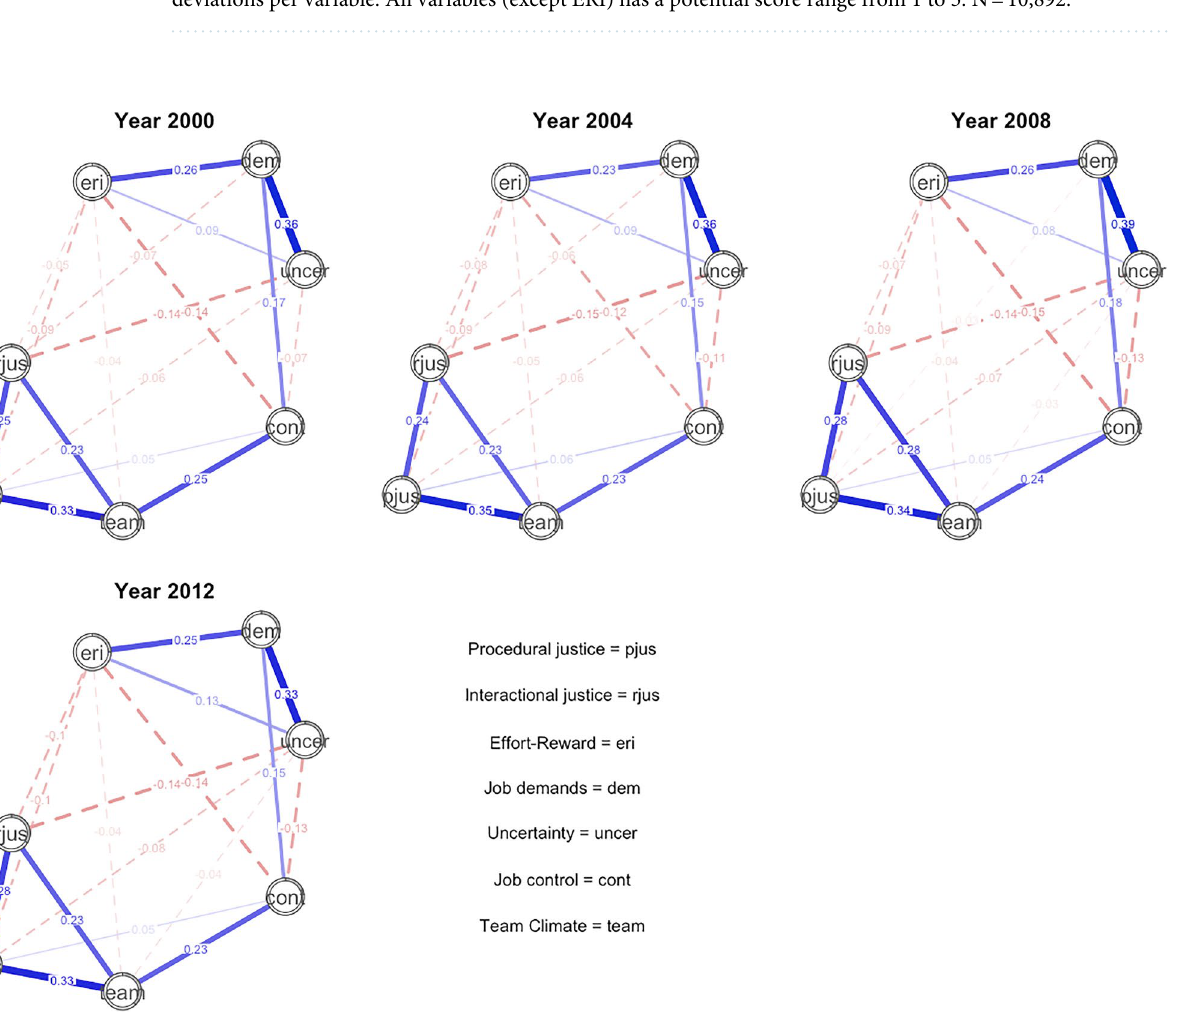
Table 1. Mean, standard deviation, and range of intra-individual means and intra-individual standard deviations per variable. All variables (except ERI) has a potential score range from 1 to 5. N = 10,892.